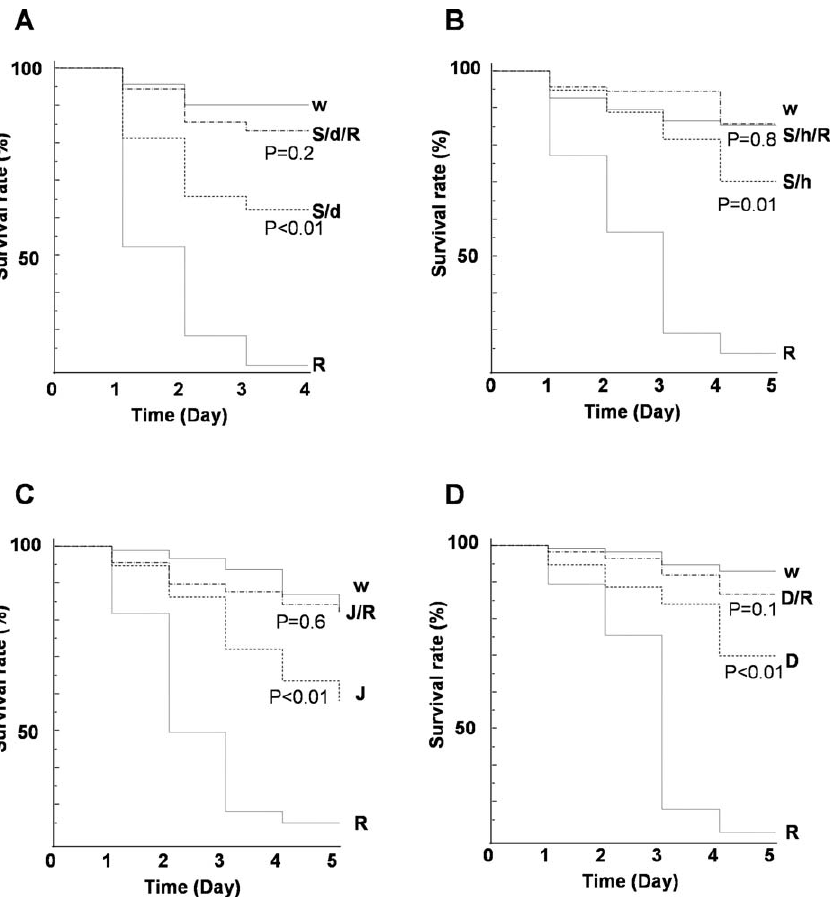
Figure 8. Lower Survival Rate Caused by Mis-Regulation of Repressosome Complex in Flies Survival of various mutant flies after bacterial infection. Three-d-old wild-type and mutant flies were infected with E. coli and their survival was measured each day after infection. Survival curves are plotted as Kaplan-Meier plots. Statistical significance is tested using log-rank analysis with MedCare software. The abbreviations used are as in Figure 7.